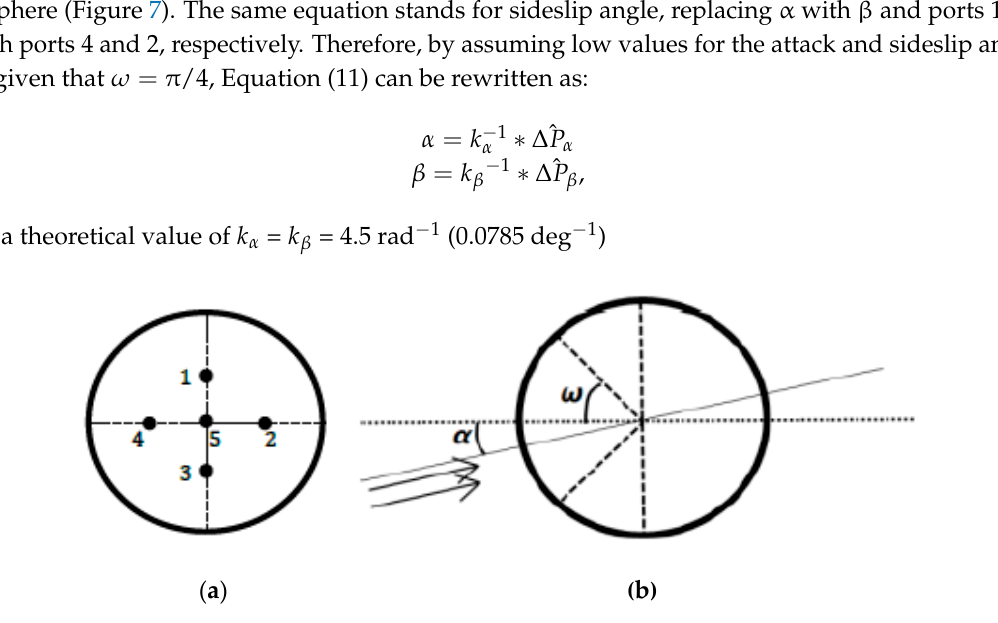
Figure 7. The five-hole probe; ( a ) front view; and ( b ) right view.